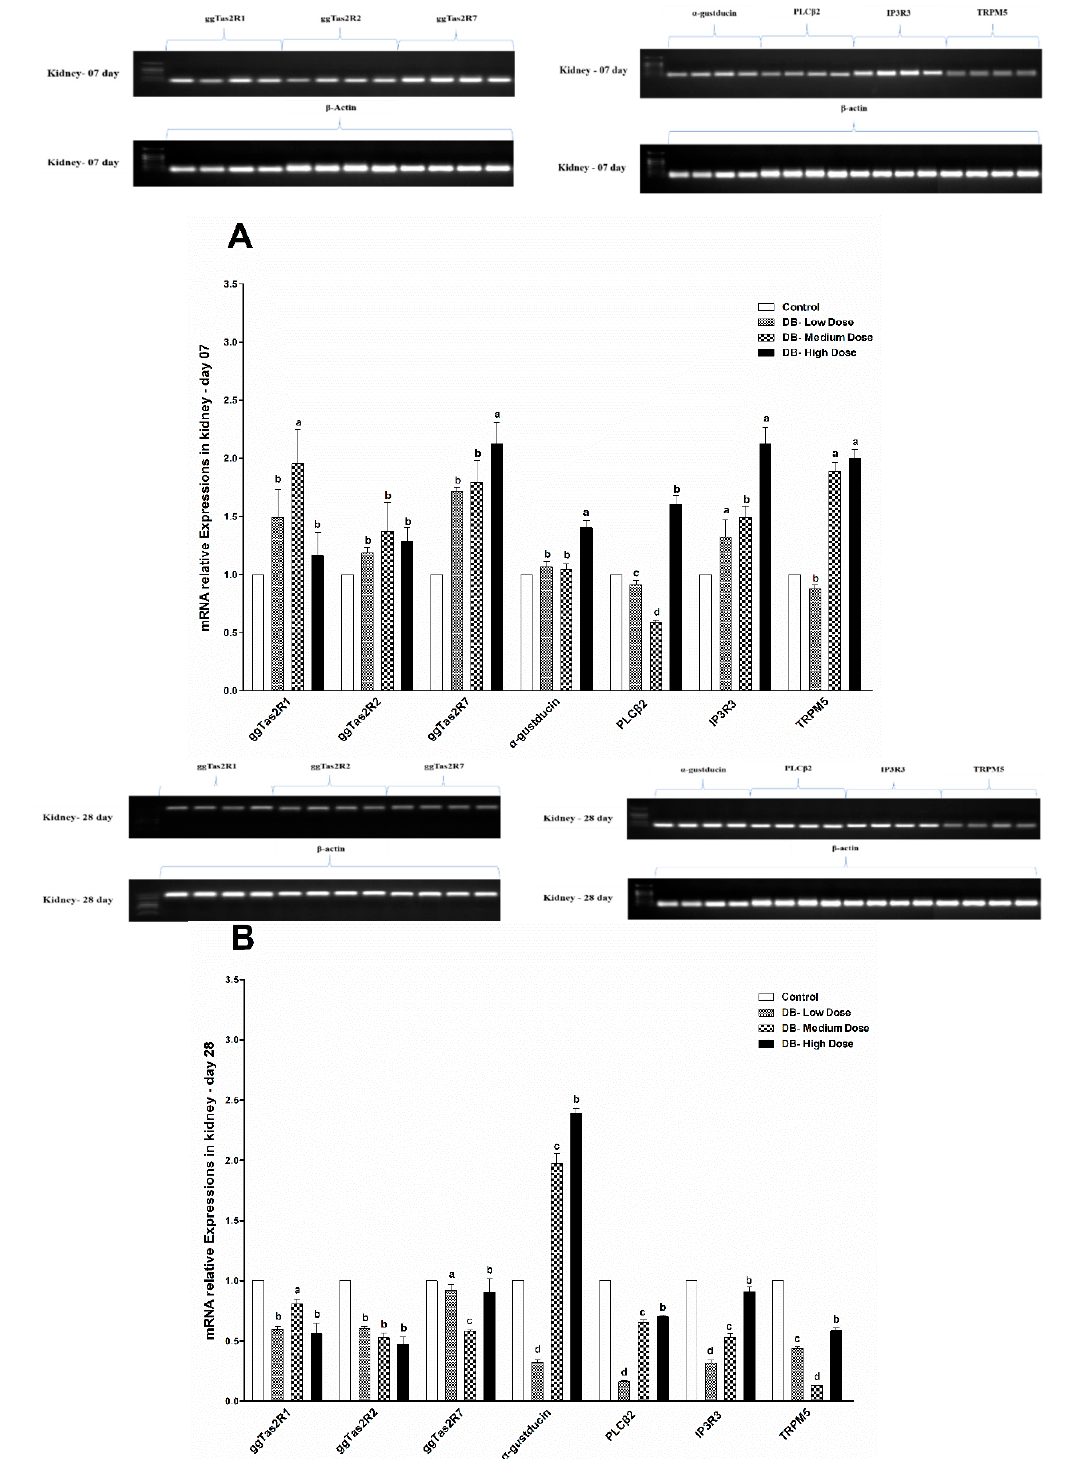
Figure 6. Effects of DB supplementation on kidney mRNA expressions of bitter taste receptors and downstream effectors at 07 days ( A ) and 28 days ( B ) of age. Data are presented as mean value ± SEM (n = 6). Values without the same mark (a–d) represent statistically significant differences ( p < 0.05). gg, Gallus gallus; PLC β 2, phospholipase C β 2; IP3R3, type 3 inositol-1,4,5-trisphosphate receptor; Denatonium benzoate- Low Dose treated group, Denatonium benzoate- Medium Dose treated group, Denatonium benzoate- High dose treated group. The results indicate that ggTas2R1, ggTas2R2, ggTas2R7 have contrary expressions in kidney on DB different doses on day-07, while ggTas2R1 expressions were highly dose-dependent in the DB medium dose group among all treated groups in day-07 (Figure 6A,B). However, on day-28 the expressions of bitter taste-related genes (ggTas2Rs) were significantly ( p < 0.05) down-regulated and there were dose-independent correlations with expressions (Figure 6B).